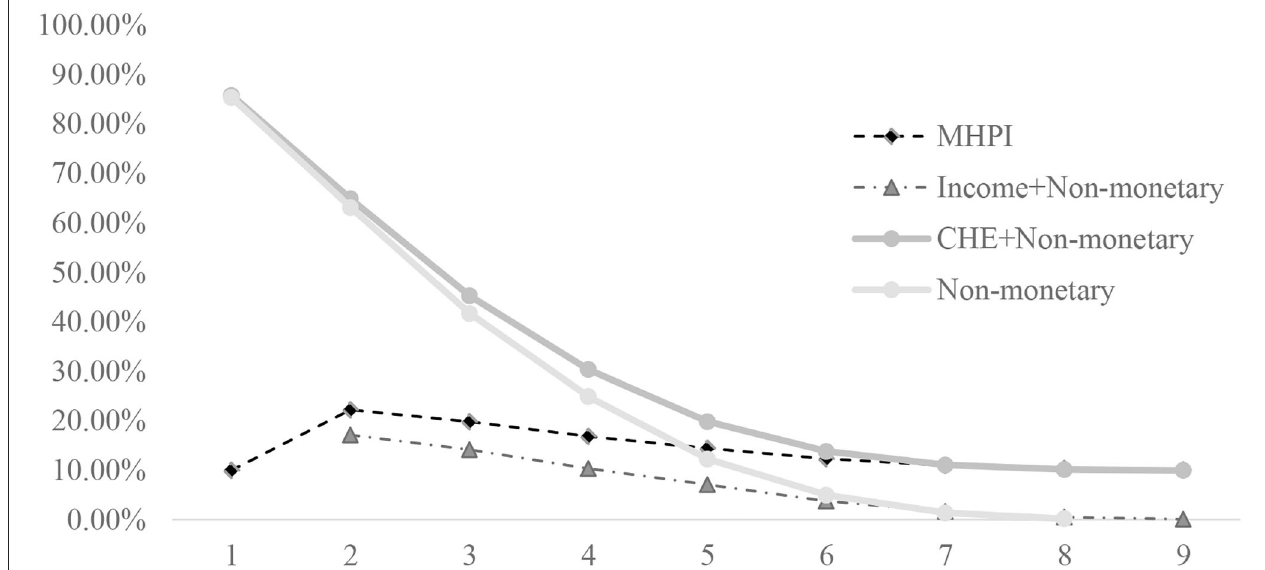
FIGURE 1 | The comparison of H between MHPI, “Income + Non-monetary MHPI,” “CHE + Non-monetary MHPI,” and “Non-monetary MHPI.” The “Income + Non-monetary MHPI” is measured by taking relative income poverty as a necessary condition with eight non-monetary indicators in the A–F method. The “CHE + Non-monetary MHPI” is measured by taking CHE as a sufficient condition with 8 non-monetary indicators in the A-F method. The “Non-monetary MHPI” is measured only with 8 non-monetary indicators in the A–F method.